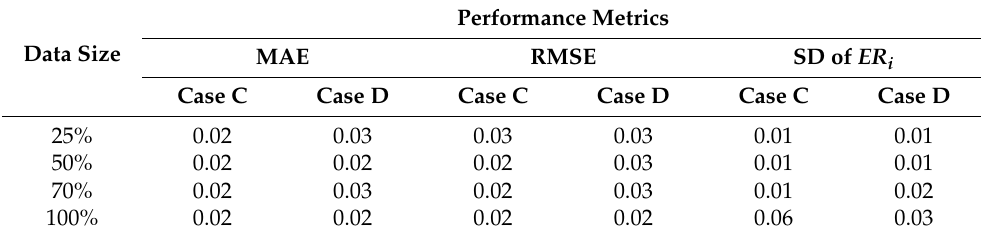
Table 4. Performance Metrics for the BiLSTM